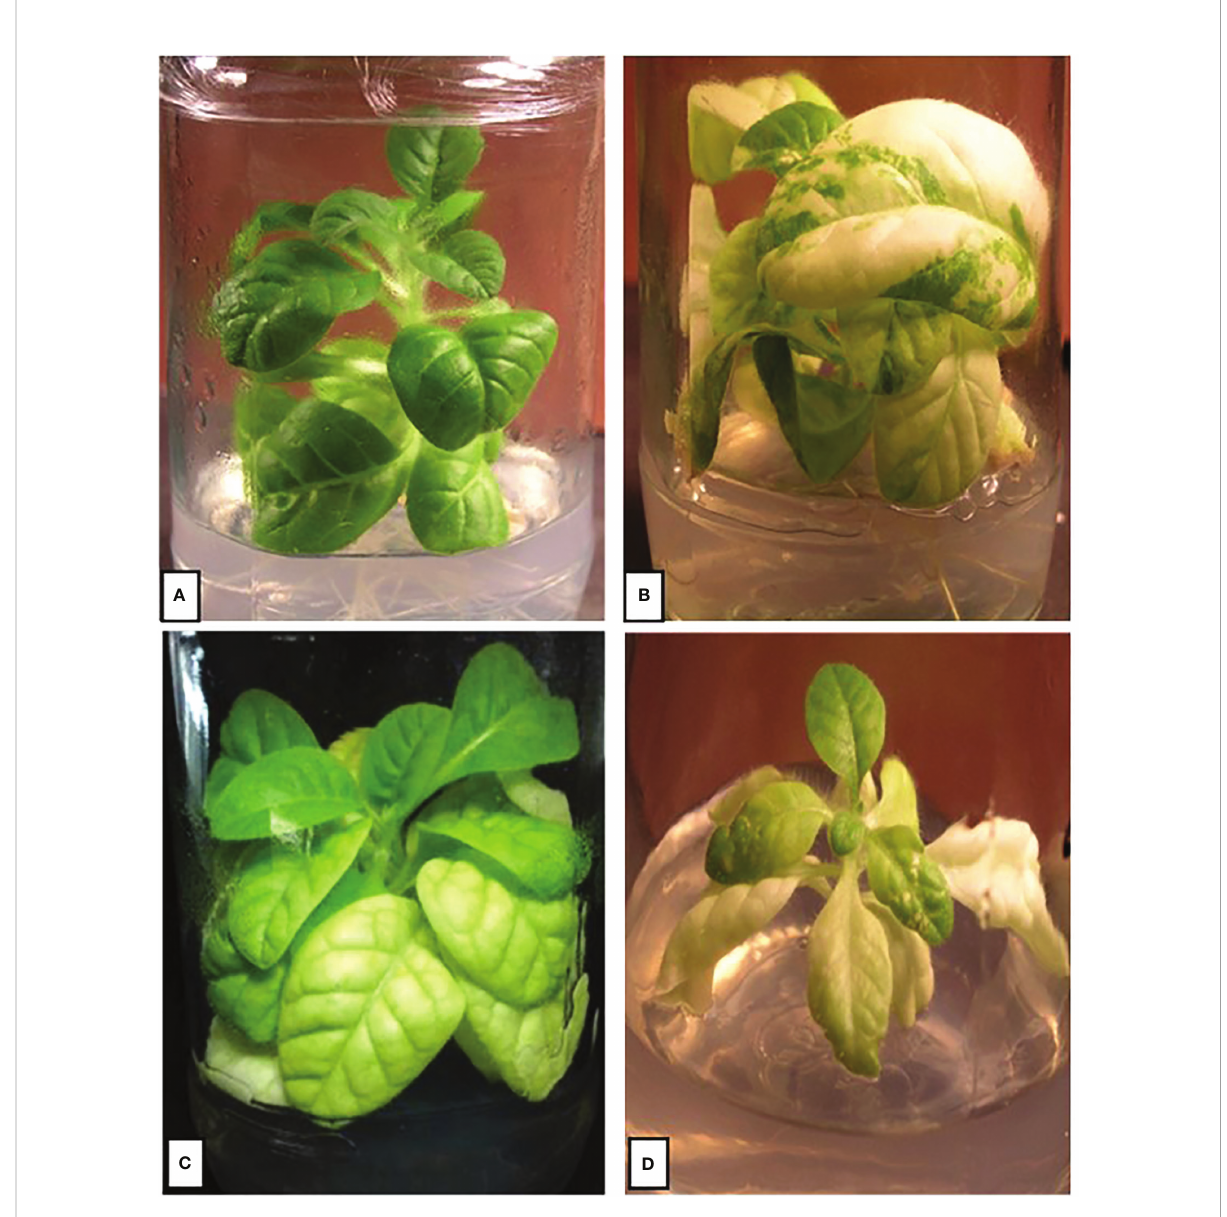
FIGURE 1 Puri fi cation of D ycf4 plants on spectinomycin-containing selection and regeneration medium. (A) Wild-type tobacco plants with intact ycf4 showing normal growth with lush green leaves. (B) Heteroplasmic plant showing leaves carrying chimeric tissues with both knocked-out and wild-type cells. (C) Homoplasmic D ycf4 tobacco plant growing under low light. (D) Homoplasmic D ycf4 tobacco plant growing under normal